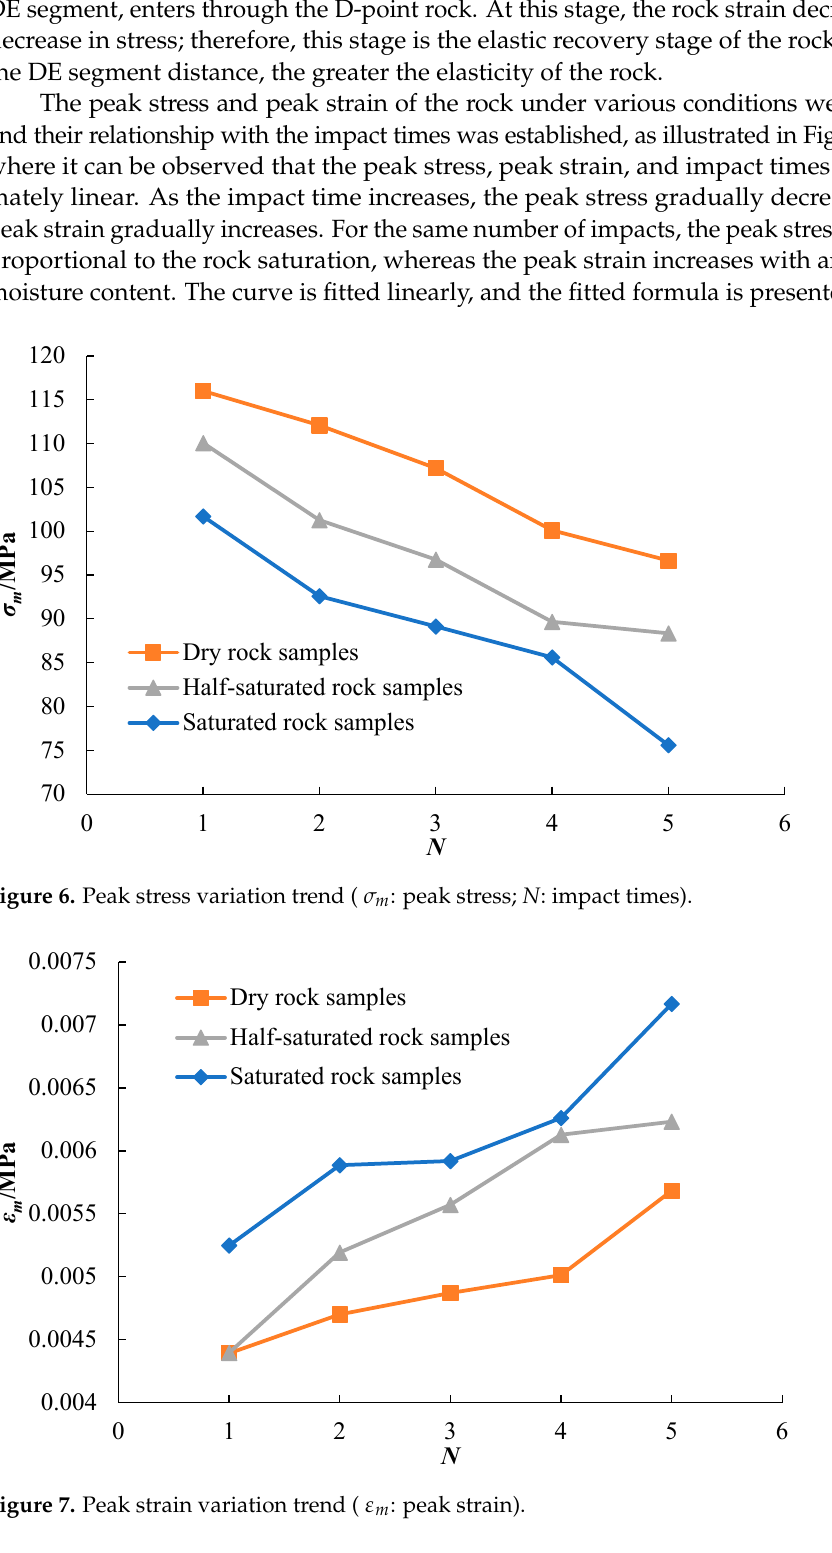
Figure 5. Typical stress ‐ strain curves.